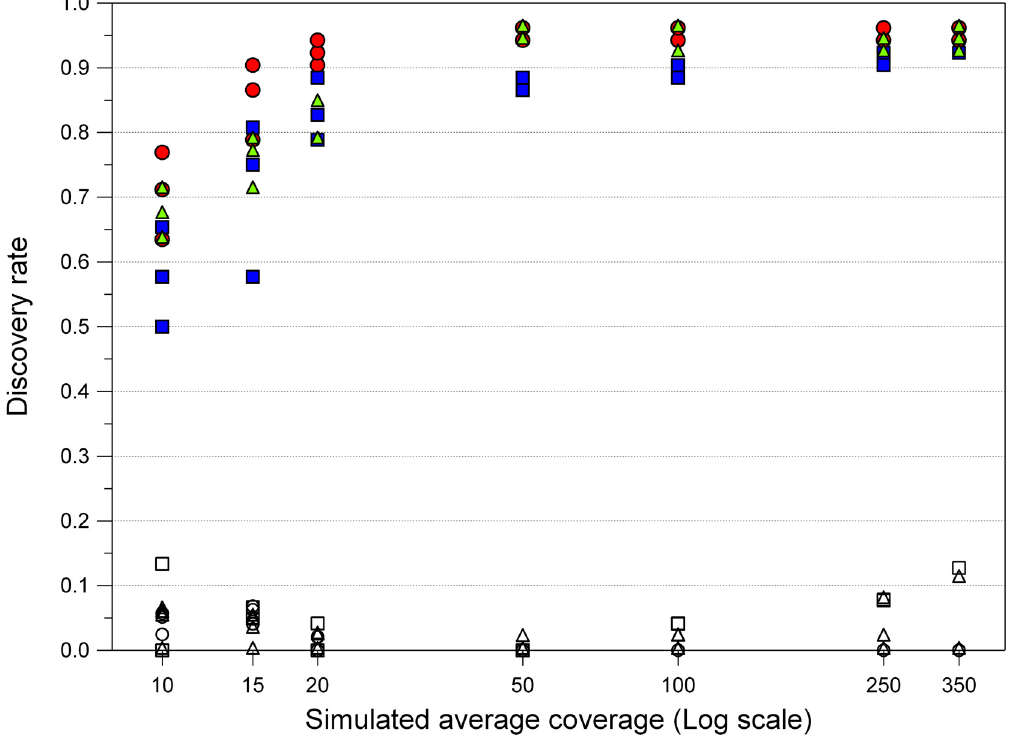
Figure 4. SNP discovery rate at simulated coverage depths. We tested seven average coverage depths, with three random samples for each point. SNPs and false positive hits are indicated by filled and open symbols, respectively. Squares, Roche 454; circles, Illumina GA; triangles, ABI SOLiD.